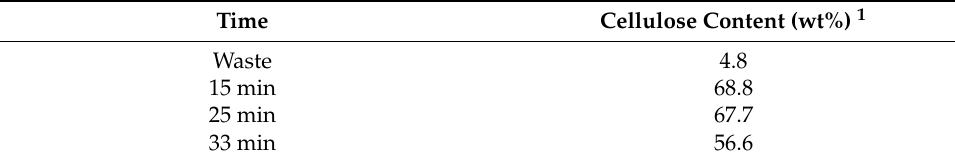
Table 3. Cellulose content calculated from DTA data as a function of the steam-explosion stage time.